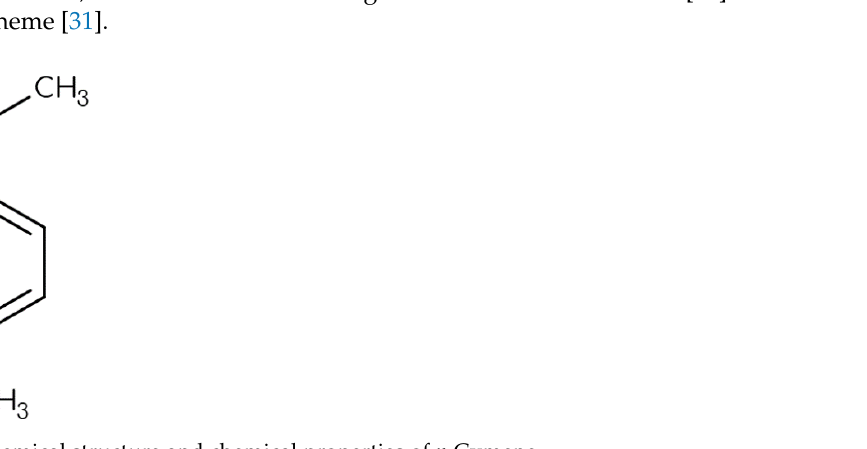
Figure 1. Chemical structure and chemical properties of p -Cymene.